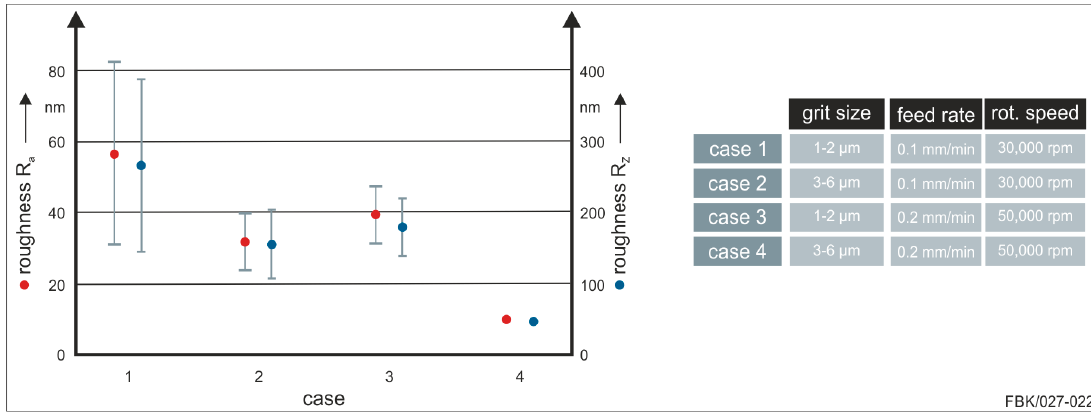
Figure 8. Bottom surface roughness of first 100 µm groove length.